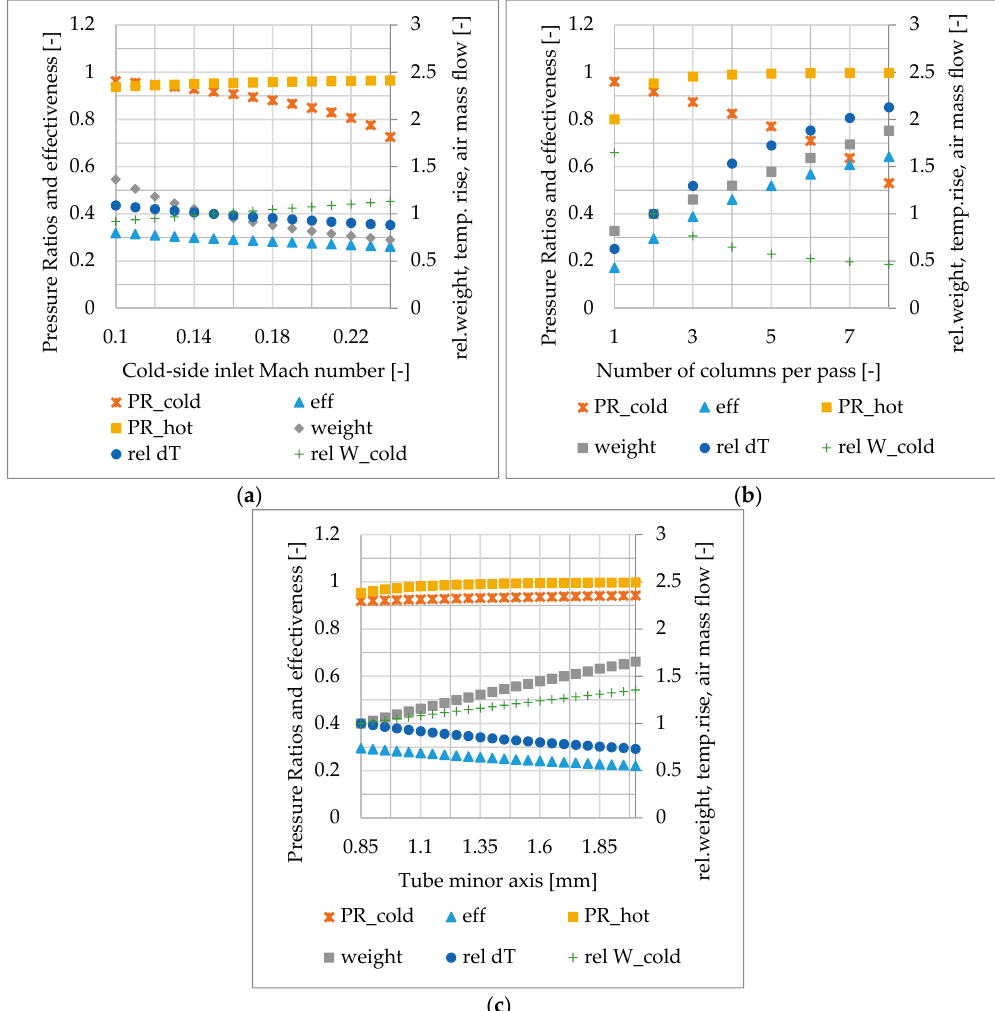
Figure 8. Parametric studies of the Pre-cooler of: ( a ) the cold-side inlet Mach number; ( b ) the number of columns per pass; and ( c ) the tube dimensions